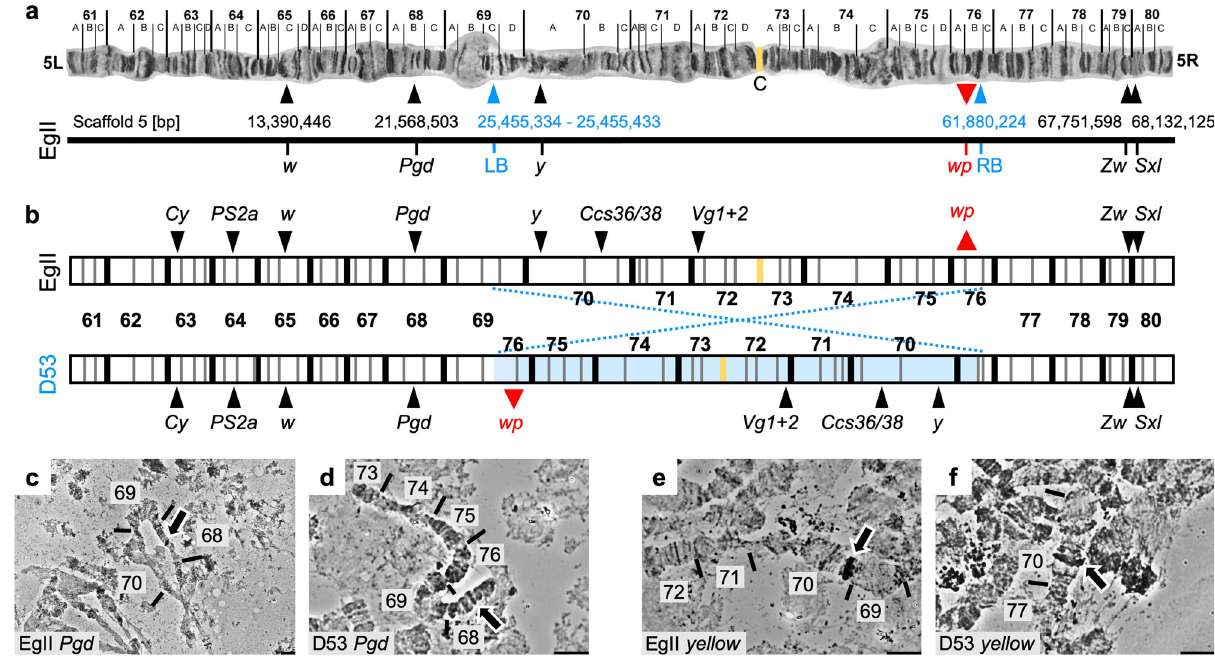
Fig. 2 Genomic positioning of the D53 inversion on chromosome 5 of C. capitata . a Chromosome scale assembly of C. capitata EgII chromosome 5. Shown are the positions of in situ mapped genes white ( w ), 6-phosphogluconate dehydrogenase ( Pgd ), glucose-6-phosphate 1-dehydrogenase ( Zw ), and sex lethal ( Sxl ), the position of the D53 inversion breakpoints (blue; LB = left breakpoint, RB = right breakpoint), and the relative position of white pupae ( wp ) on the polytene chromosome map of chromosome 5 71 (left (L) and right (R) chromosome arm, linked at the centromeric region (C)) and the PacBio-Hi-C EgII scaffold_5 (bp = base pairs), representing the complete chromosome 5 (Ccap3.2.1, accession GCA_905071925). The position of the yellow gene ( y , LOC101455502) was con fi rmed on chromosome 5 70A by in situ hybridization, despite its sequence not been found in the scaffold assembly. b Schematic illustration of chromosome 5 without (EgII, WT) and with (D53) D53 inversion, with additional marker genes Curly ( Cy ), integrin-aPS2 ( PS2a ), white ( w ), chorion S36/38 ( Ccs36/38 ), vitellogenin-1/2-like ( Vg1 + 2 ). The inverted part of chromosome 5 is shown in light blue, the centromere in yellow. Two probes, one inside ( y , 70A) and one outside ( Pgd , 68B) of the left inversion breakpoint were used to verify the D53 inversion breakpoints by in situ hybridization. WT EgII is shown in c and e , D53 in d and f . Chromosomal segments are numbered, arrows in micrographs indicate in situ hybridization signal. In situ hybridizations were done at least in duplicates and at least ten nuclei were analyzed per sample, scale bar = 10 µ m. All replicates led to similar results. The source data underlying Fig. 2c – f are provided as a Source Data fi